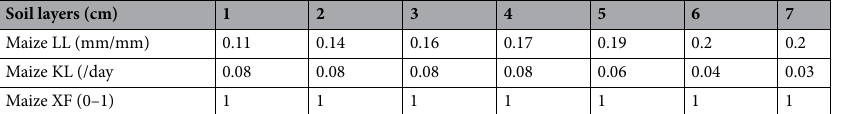
Table 2. Crop’s LL = lower limit (water content at -15 bar pressure potential), KL = rate of water extraction XF parameters of the APSIM model at Jilin site. There are seven layers in from 0 to 180 cm.